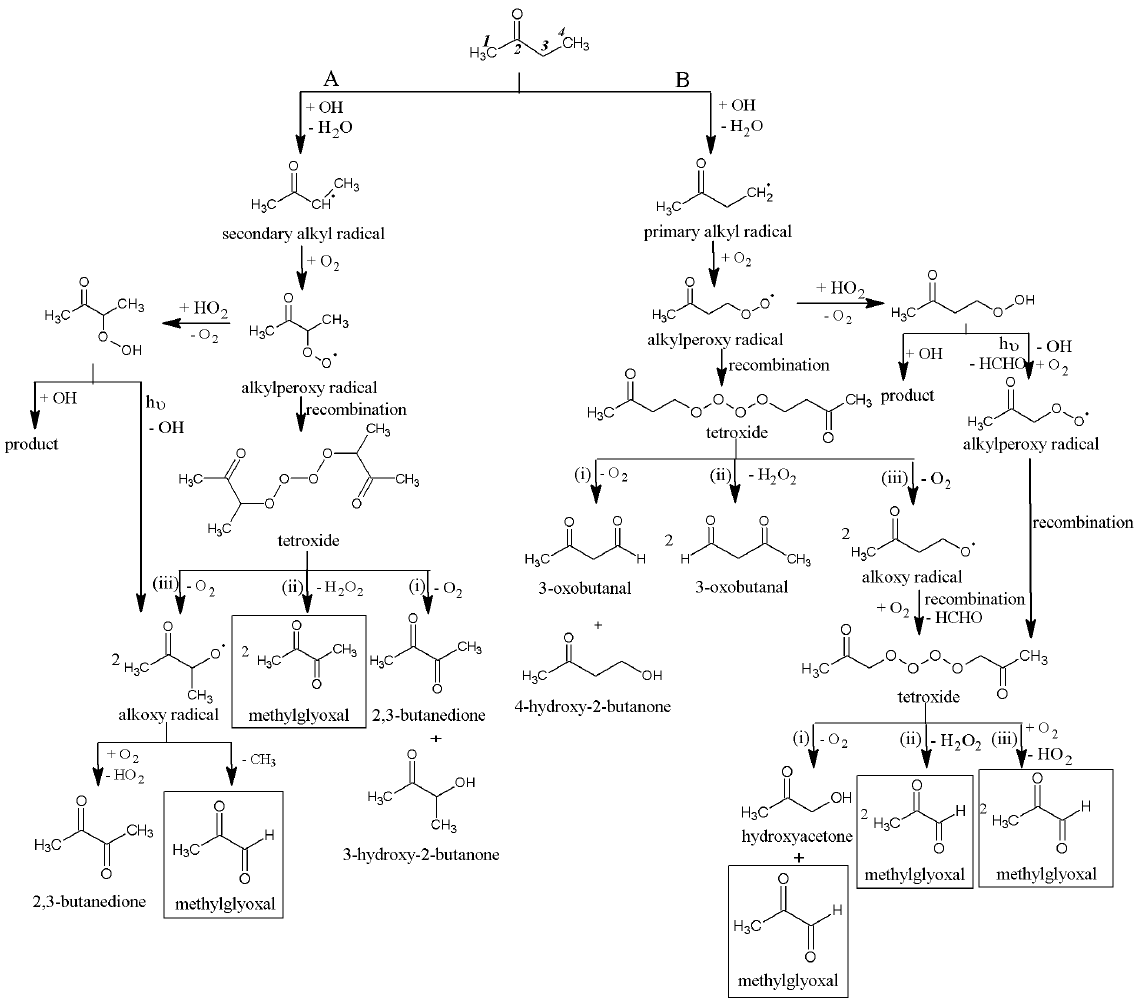
Figure 4. Recommendation of an oxidation mechanism of MEK for the formation of 2,3-butanedione, hydroxyacetone, and methylglyoxal.